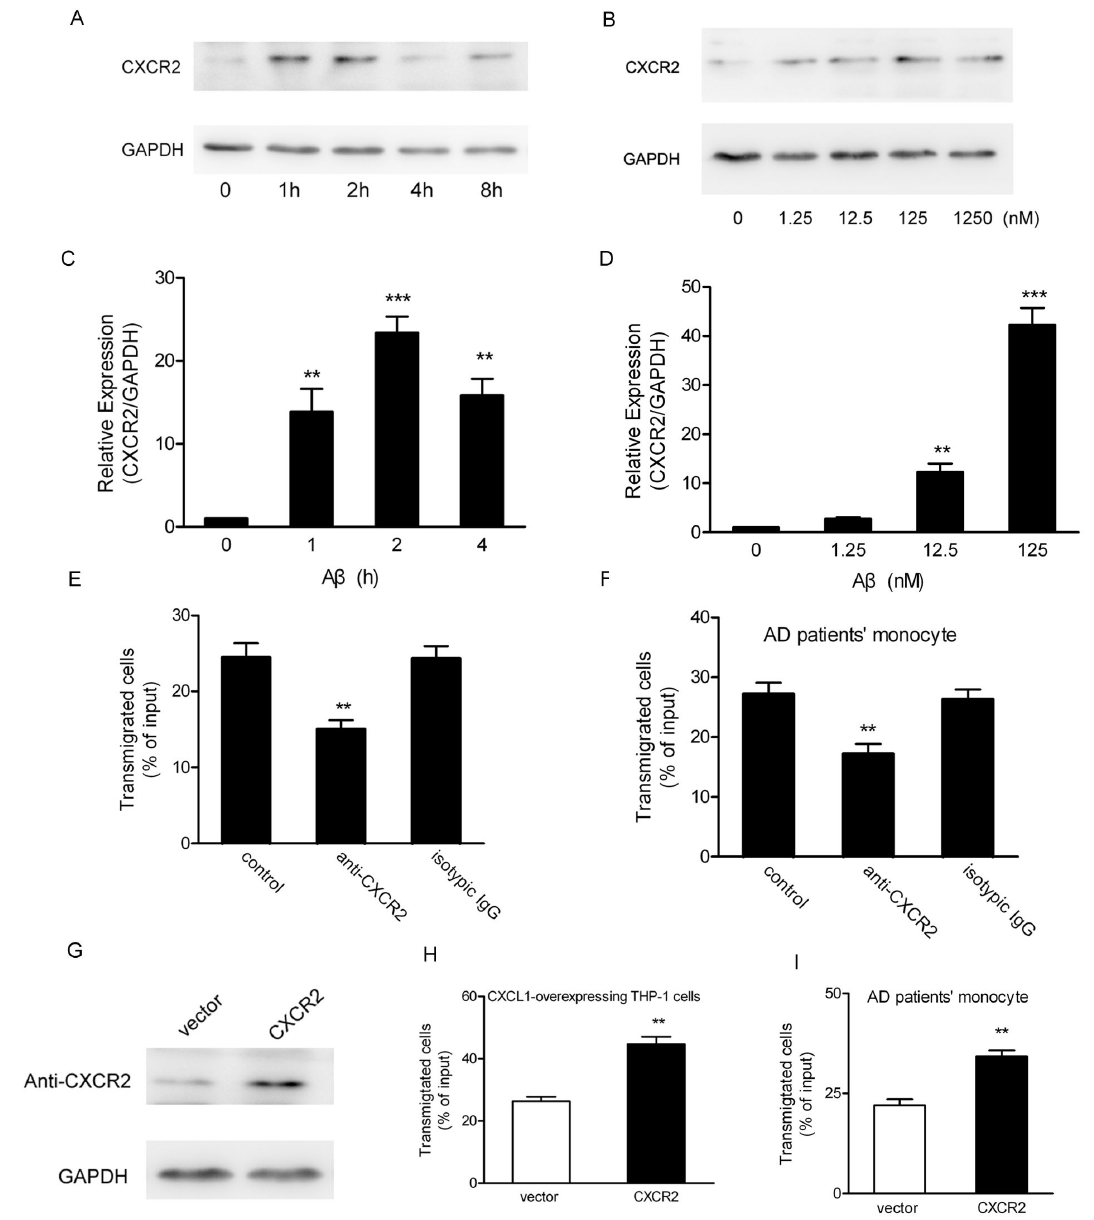
Figure 4. CXCR2 in HBMEC was up-regulated by Aβ sitmulation and contributed to CXCL1-overexpressing THP-1 cells transendothelial migration. (A) HBMEC were exposed to Aβ for indicated time at a concentration of 125 nM or (B) indicated concentrations for 1h. CXCR2 expression on HBMEC was detected by Western blot using anti- CXCR2 antibody. Untreated HBMEC were used as control. (C) HBMEC were incubated with Aβ for indicated times at a concentration of 125 nM, or with indicated concentrations for 1h (D), and the total RNA of HBMEC was extracted for real-time RT-PCR. Expression was normalized to GAPDH and the group without Aβ was set to 1. Data were the mean ± SD (n=3). * p < 0.05. The HBMEC monolayer cultured on the Transwell insert was placed on a 24-well plate while Aβ was present in the lower chamber. CXCL1-overexpressing THP-1 cells (cid:0) E) or AD patients’ monocytes (cid:0) F) with anti-CXCR2 neutralizing antibody were loaded into the upper chamber. The cells transmigrated into the lower chamber were counted after 24h. Data were mean±S.D. ** p < 0.01. (G) The HBMEC expressing full-length ORF of CXCR2 by transient transfection was identified by Western blot using anti-CXCR2 antibody. HBMEC transfected with vector were used as control. CXCL1-overexpressing THP-1 cells (H) or AD patients’ monocyts (I) were loaded into upper chamber of Transwell insert cultured with HBMEC transfected with CXCR2. The transmigrated monocytes were counted. Data were the mean ± S.D. * p < 0.05, ** p < 0.01. doi: 10.1371/journal.pone.0072744.g004 PLOS ONE |